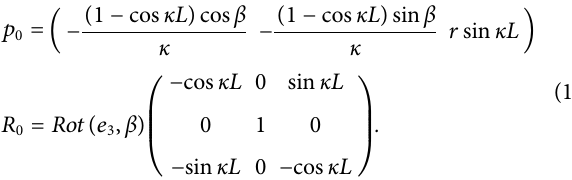
Frontiers in Robotics and AI |